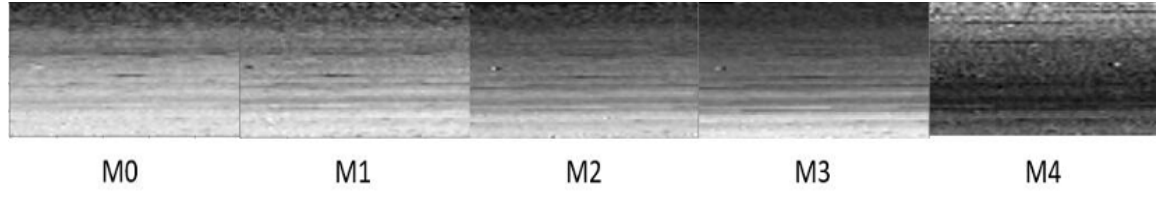
Figure 13. Spectra after 2D folding processing.